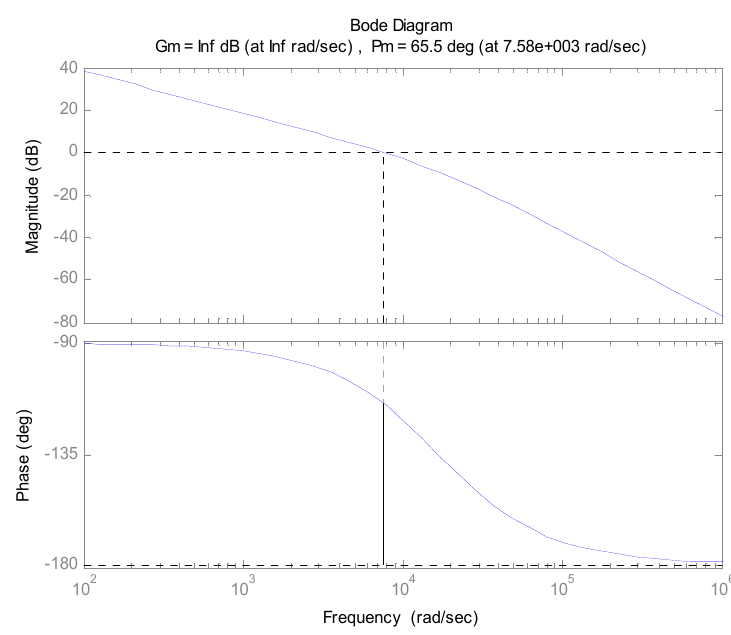
Figure 8. Simulation correction results of open current loop for pitch system.